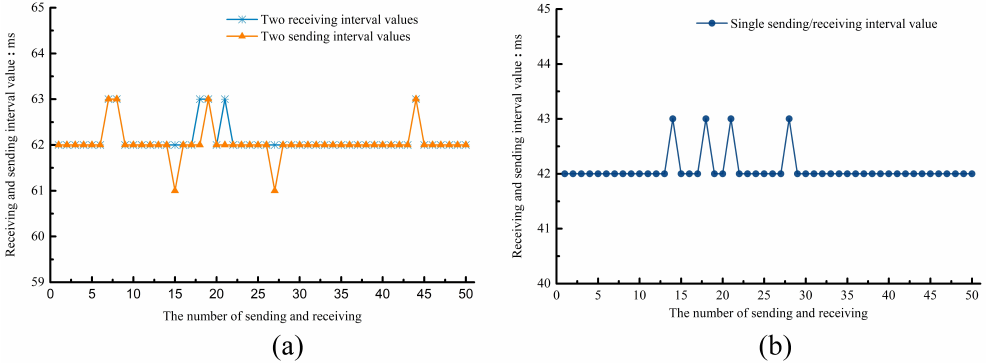
Figure 10. The interval values are the time for the test software to send and receive data under fixed load. Judging the capability of the DPU’s digital output by its two interval values. ( a ) Statistics of DO sending and receiving interval values. ( b ) Statistics of DO sending and response data